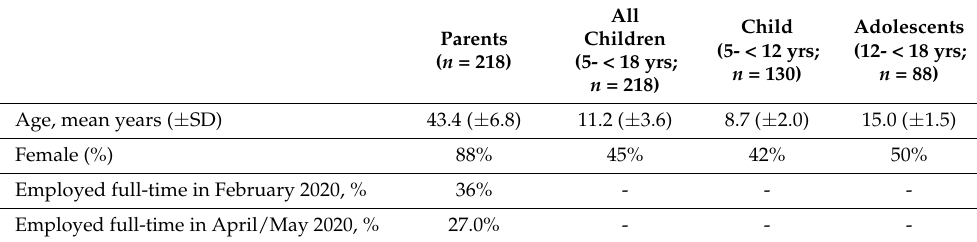
Table 1. Participant